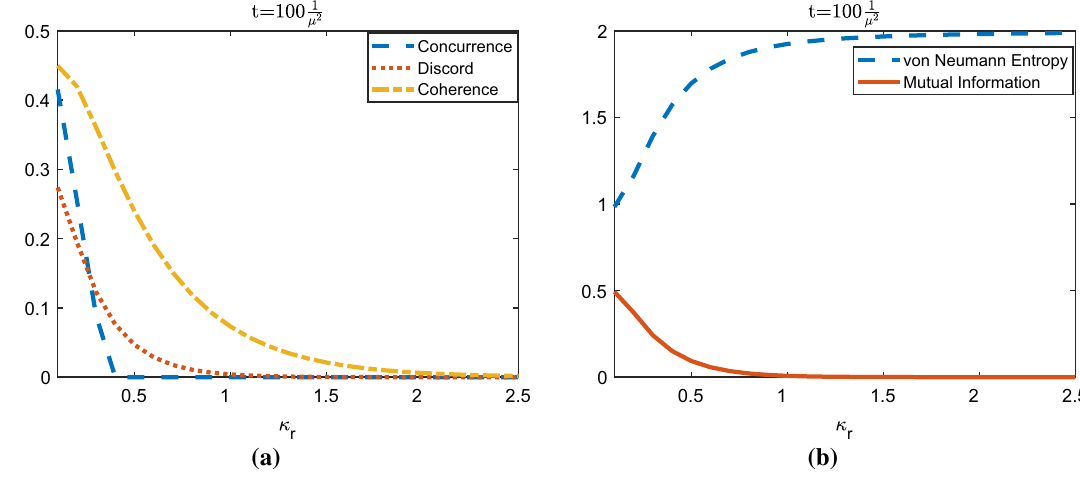
Fig. 7 Quantum correlations at nonequilibrium transient state vs. κ r when t = 100 μ